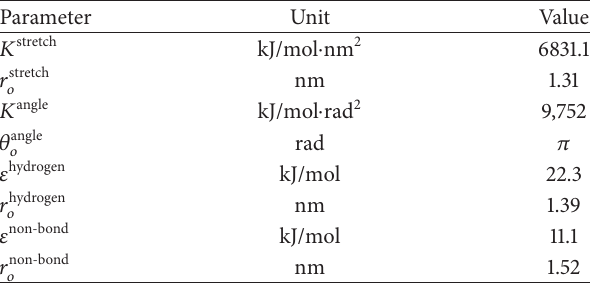
Table 1: Coarse-grained PPTA force-field parameterization used in the present work. Please see (1)–(4) for explanation of the